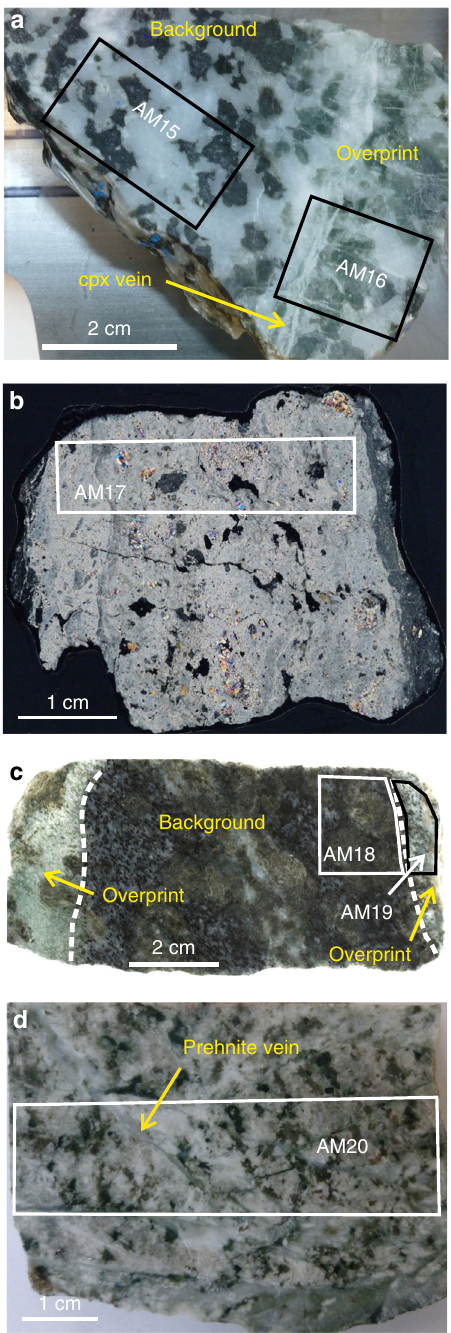
Fig. 1 Samples analysed in this study. a U1415P 23R1 85 – 90 solid block, showing approximate locations of samples AM15 and AM16 (Table